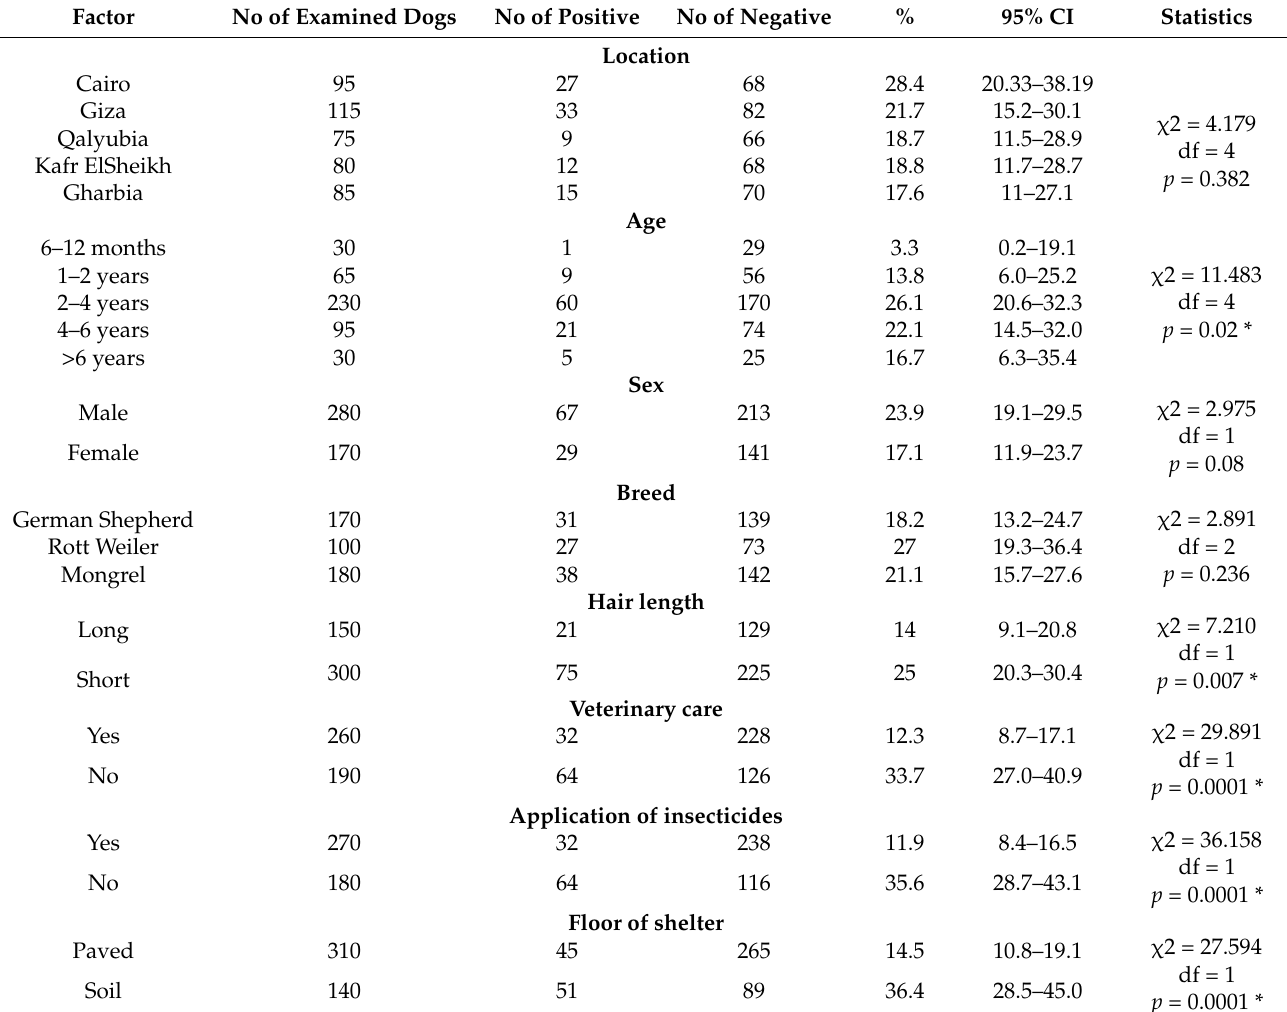
Table 1. Seroprevalence of canine leishmaniasis in relation to different